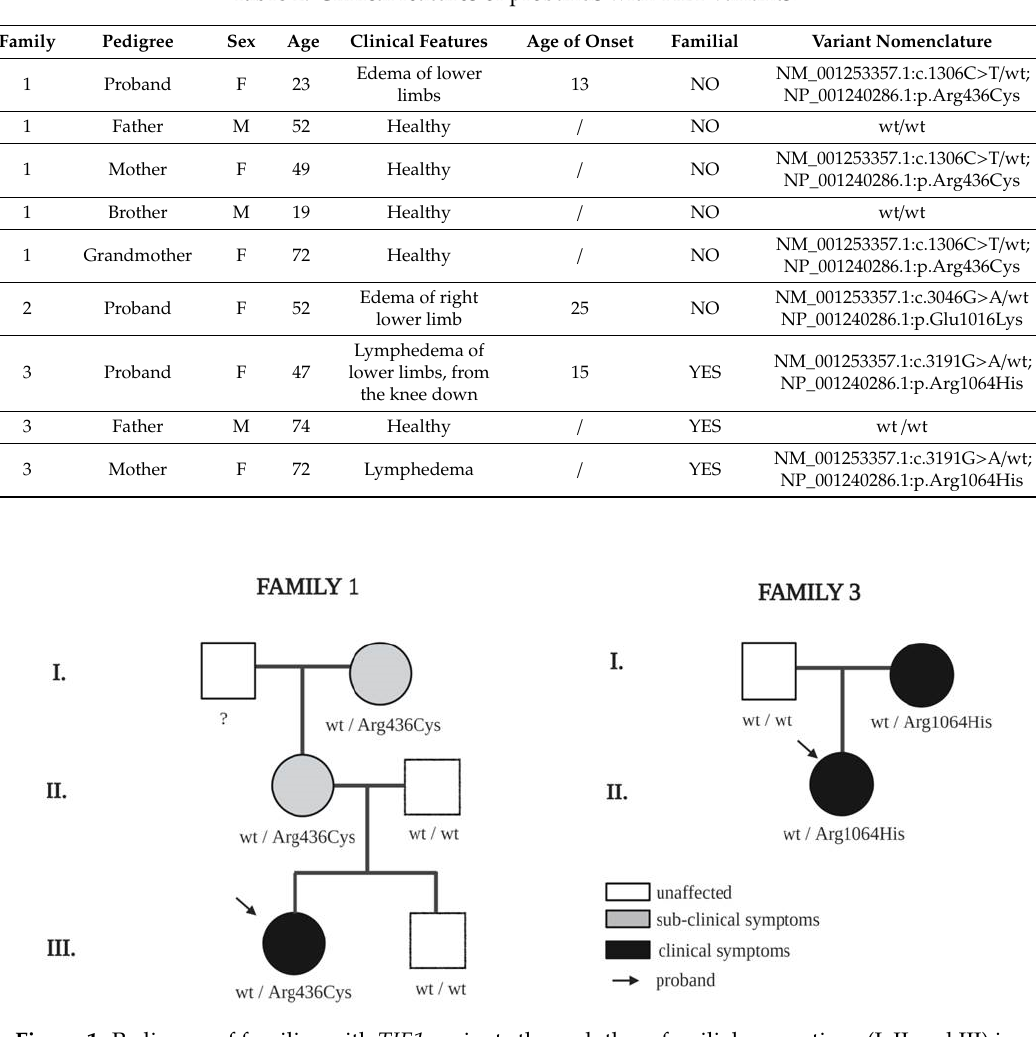
Figure 2. Modelled structure of the TIE1 gene in ( a ) ribbon ( b ) schematic and ( c ) CPK view. Cyan regions indicate beta sheets, white indicates loops and red indicates alpha helices. 2.2. In-Silico Analysis, Template Selection and Model Building A template search with BLAST and HHBlits was performed against the SWISS-MODEL template library (SMTL, last update: 24 October 2019, last included PDB release: 18 October 2019). The target sequence (Table 4) was searched against the primary amino acid sequence contained in